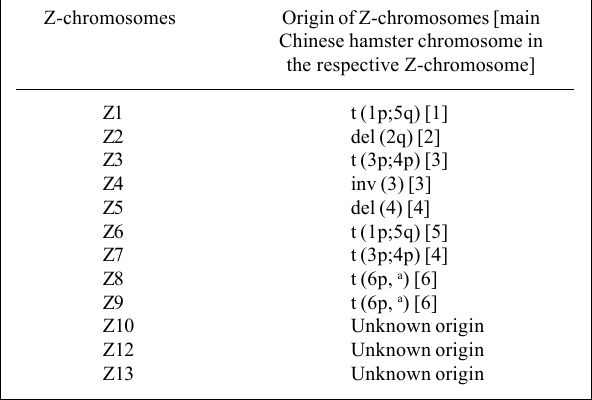
Table I - Description of rearranged CHO9 chromosomes (Z). In addition to Z-chromosomes there are the following seemingly normal Chinese hamster chromosomes: 1, 2, 5, 7, 8, 9, 10, X. With the exception of two chromosomes 8, all the others including the Z-chromosomes are present in one